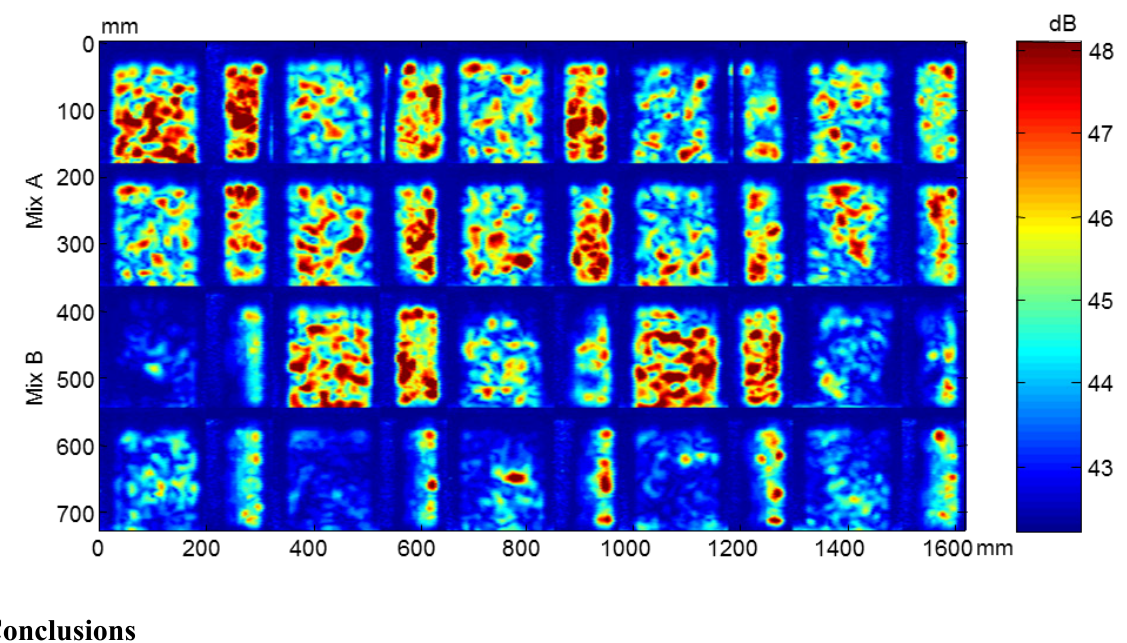
Figure 27. Attenuation maps of concrete specimens after the